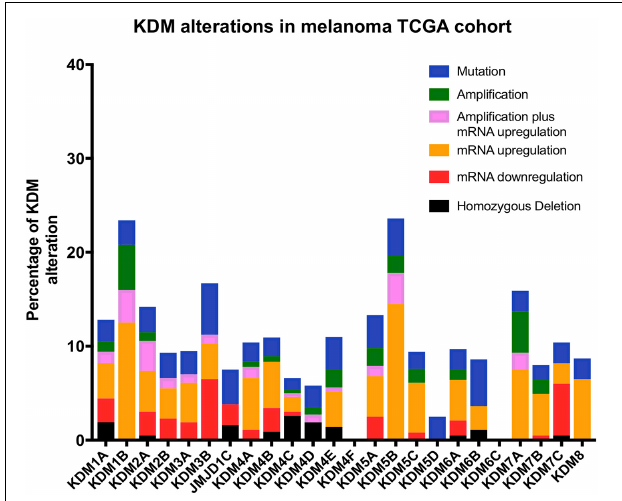
FIGURE 3 | Bar graph showing the percentage and type of each KDM mutations obtained from the cancer genome atlas (TCGA) database. The data was obtained from a total of 472 patients with skin cutaneous melanoma (SKCM).